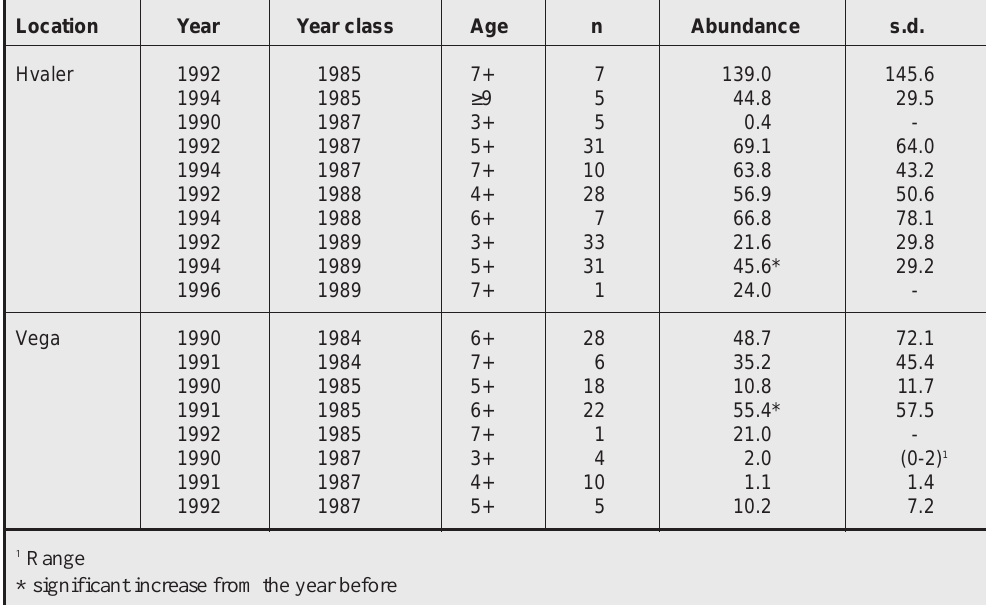
Table 5 . Variation of P. decipiens abundance with host age in selected year classes of sculpins sampled at Hvaler and Vega.